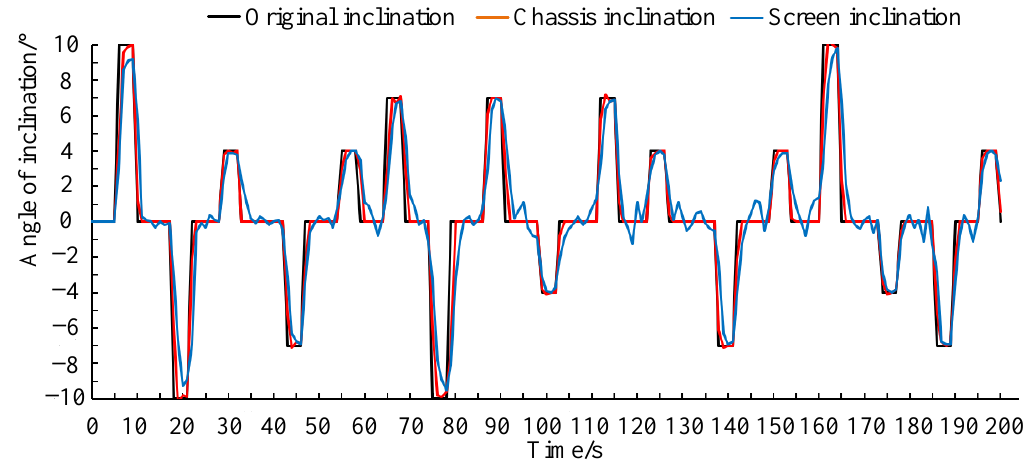
10 Figure 11. Comparison of PID and fuzzy PID. 4.4. Field Validation Test The field validation test was conducted in Liyang, Changzhou, on June 4, 2022. The harvested crop was rape, with a height of 2 m, row spacing of 50 cm, plant spacing of 25 cm, and stubble height of 90 cm. First, a road surface 200 m long is measured at the test site. A 5 m long boss is placed at each end of the road where the left and right tracks pass. The height of the boss is just enough to enable the combine harvester to obtain 4°, 7°, and 10° inclinations. There are 1 m ascending and descending sections at the front and rear ends of the boss which are conducive to the smooth climbing and descending of the tracks. The starting point and ending point are marked and the body inclination values are collected by the controller and sent to the computer through the E62DTU radio data transmission station. Another angle sensor is set on the vibrating screen to detect the screen rotation angle and send it to the computer through the radio data transmission station. When the working parts of